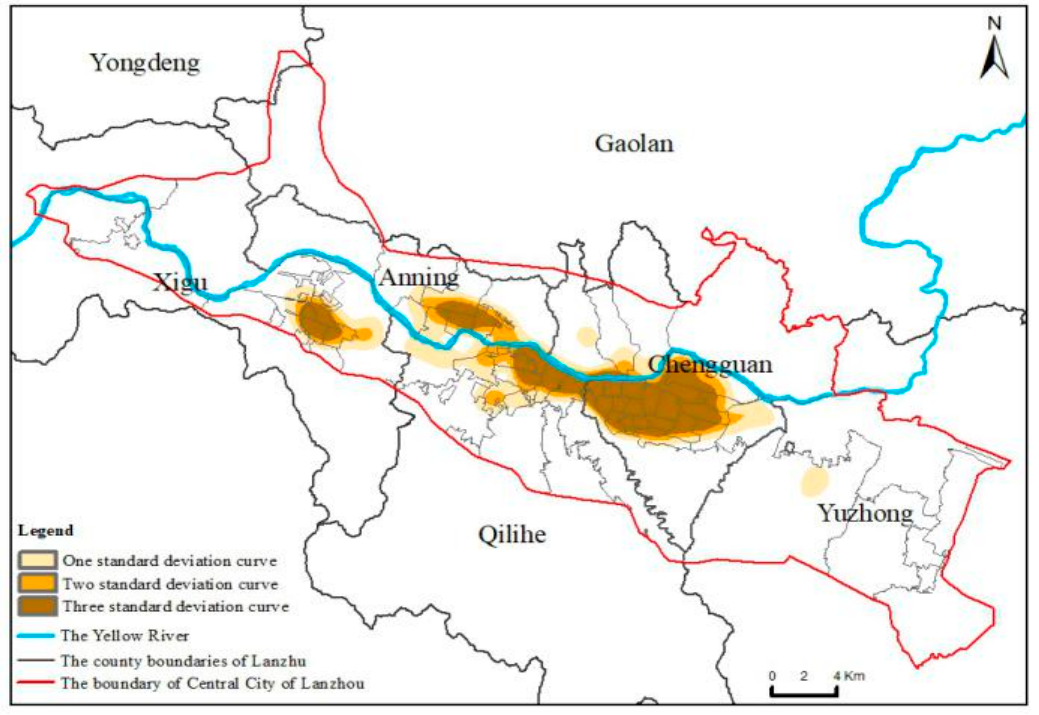
Figure 3. POI kernel density.